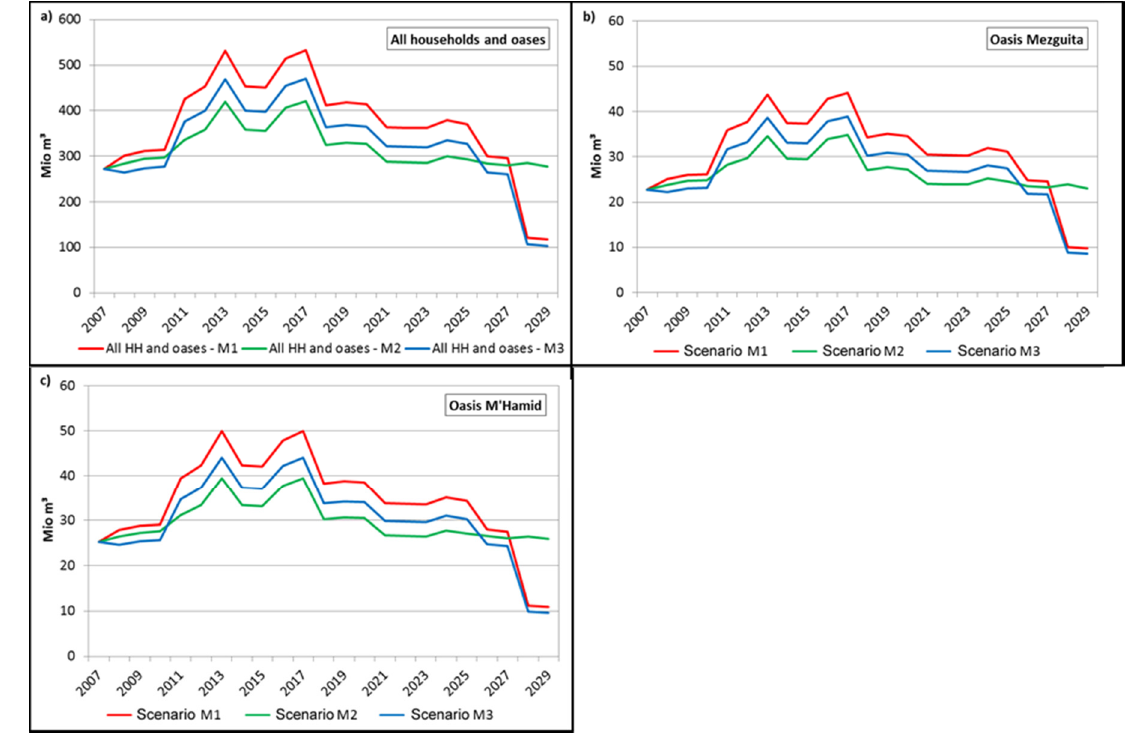
Figure 5. Mean annual water demand in million m 3 of the three IMPETUS scenarios M1 (red), M2 (green), and M3 (blue) (2007–2029) for ( a ) all demand sites; ( b ) for the oasis Mezguita; and ( c ) for the oasis M´Hamid. The drastic decrease of water demand in 2028 and 2029 in scenario M1 and M3 is caused by the reduction of the field size due to water scarcity.